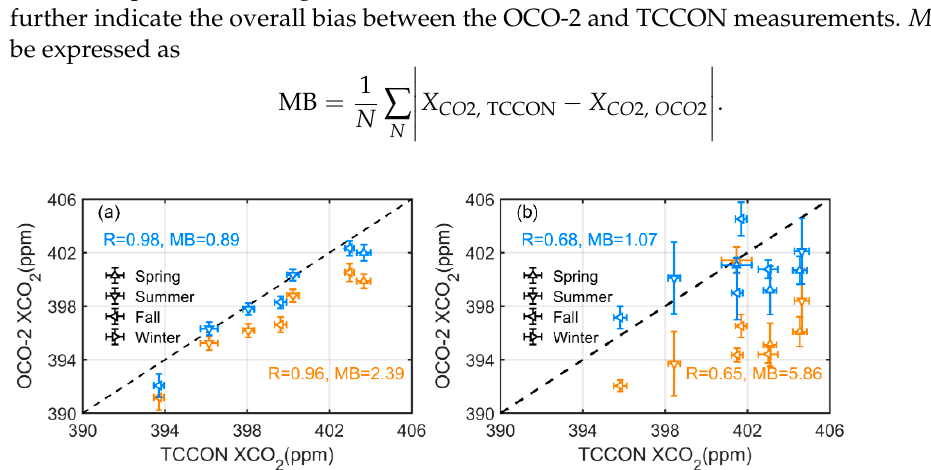
Figure 8. Scatterplots of seasonal daily average XCO 2 from OCO-2 versus collocated TCCON observations. The orange and blue dots are respective results before and after linear regression correction. The dashed line is the one-to-one ratio line. The upward, downward, left, and right triangle points represent the spring, summer, fall, and winter results. ( a ) 7 days of results at Bremen; ( b ) 9 days of results at Paris.